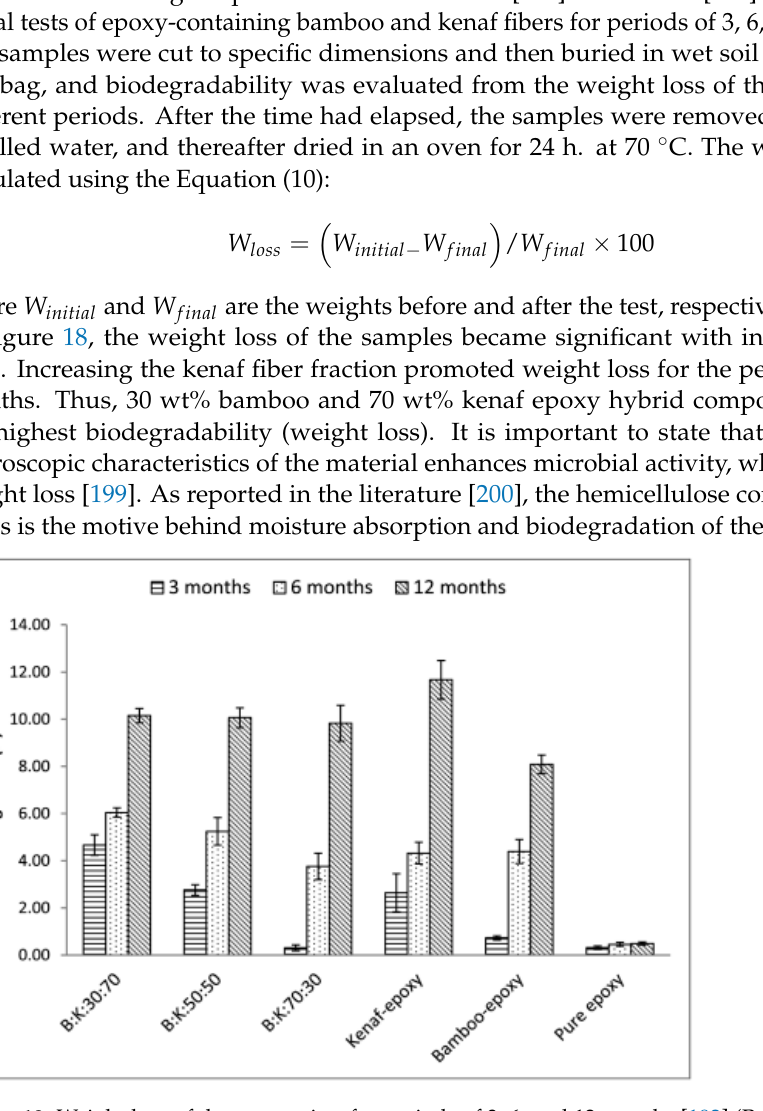
Figure 18. Weight loss of the composites for periods of 3, 6, and 12 months [192] (Reprinted/adapted with permission from Elsevier Ref.5457250582417 Copyright 2019).